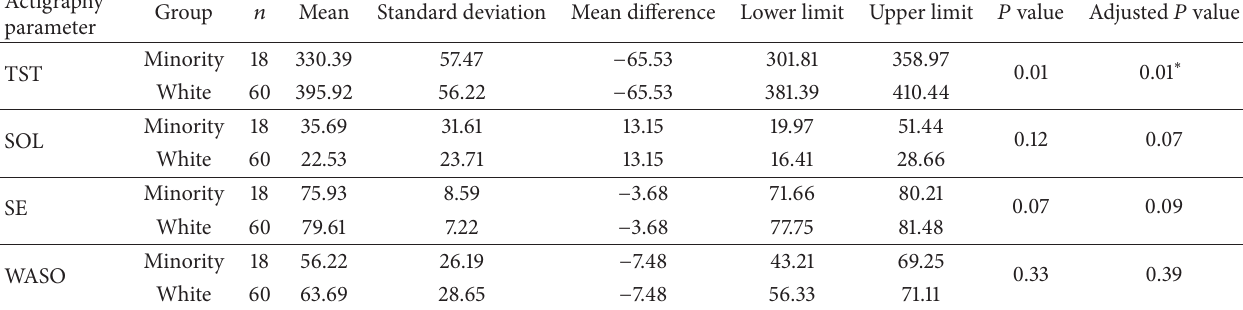
Table 3: Means, standard deviations, mean differences, lower and upper limits, and significance of actigraphy parameters of participants by race/ethnicity ( 𝑁 = 78